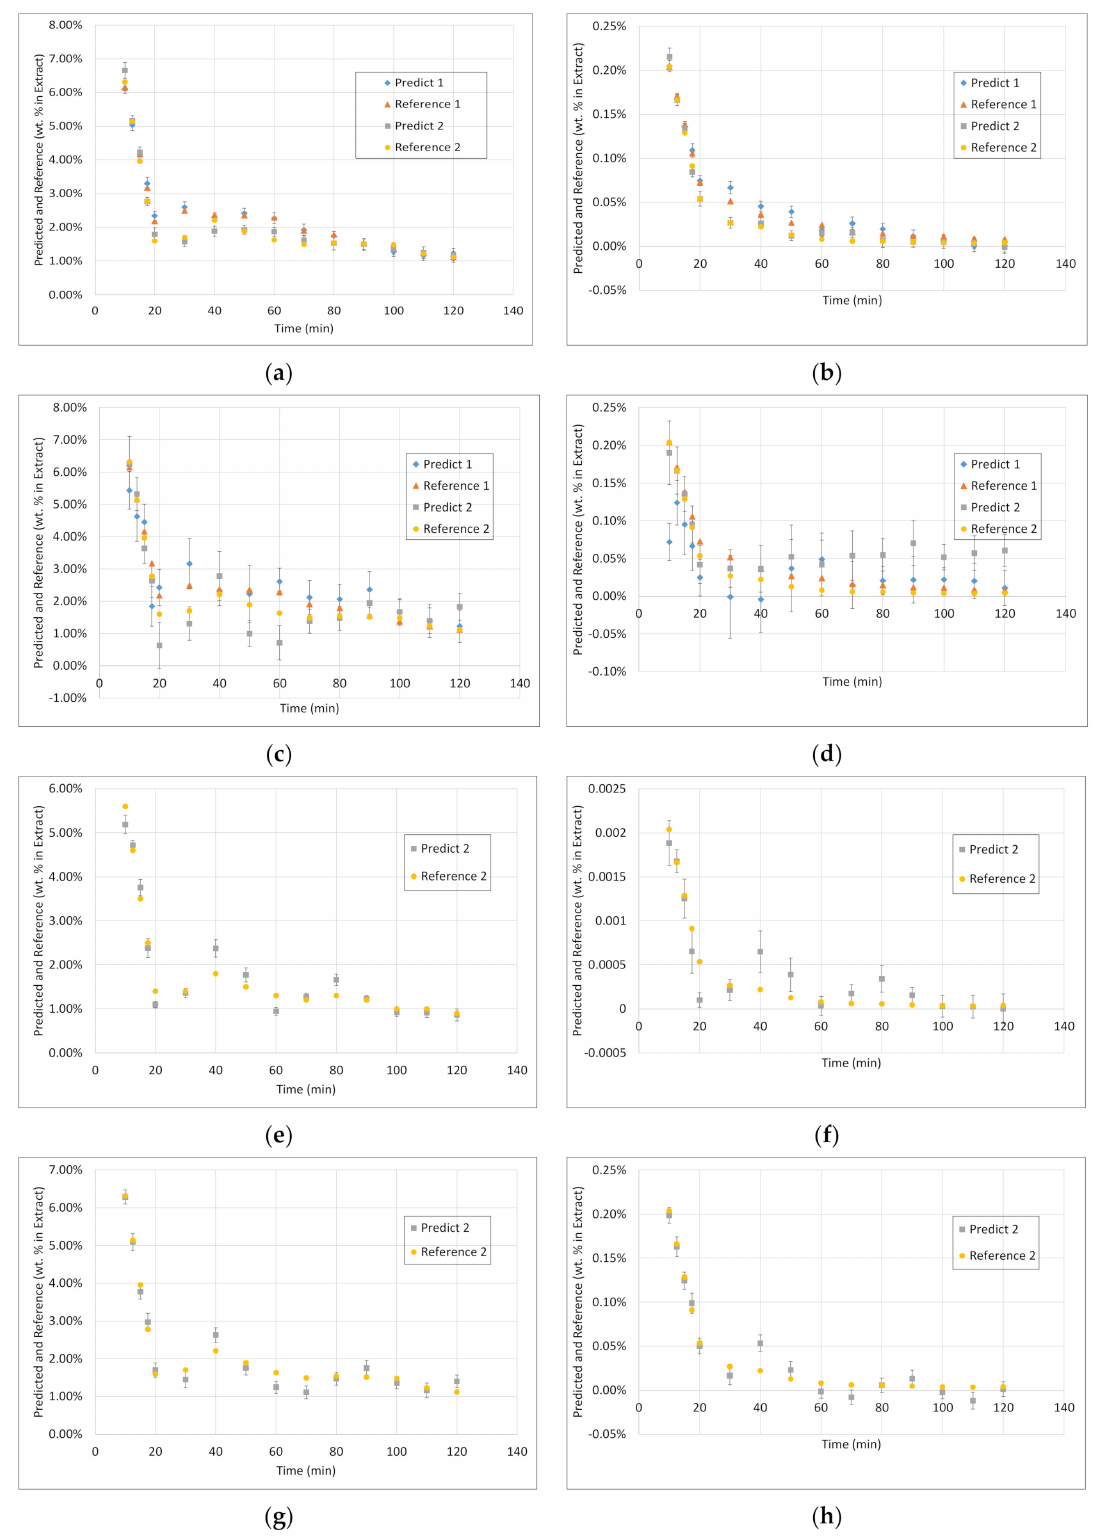
Figure 10. Extraction profiles with reference offline analytics and predicted with PLS based on spectra from extraction run 1 and 2. ( a ) Dry residue (FTIR), ( b ) arbutin (FTIR), ( c ) dry residue (Raman), ( d ) arbutin (Raman), ( e ) dry residue (DAD), ( f ) arbutin (DAD), ( g ) dry residue (fluorescence), ( h ) arbutin